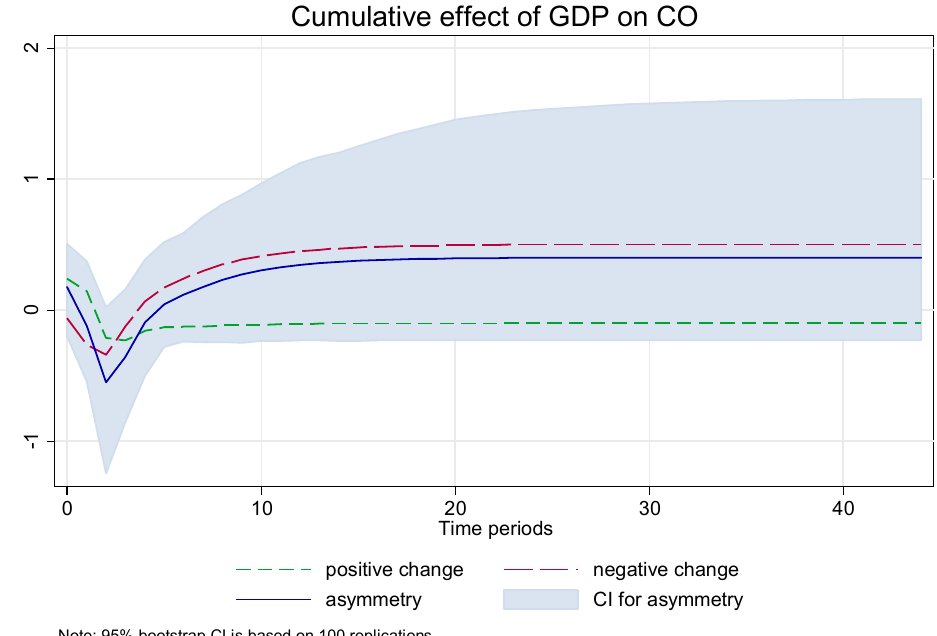
Figure A4. Cumulative effect of GDP on CO.